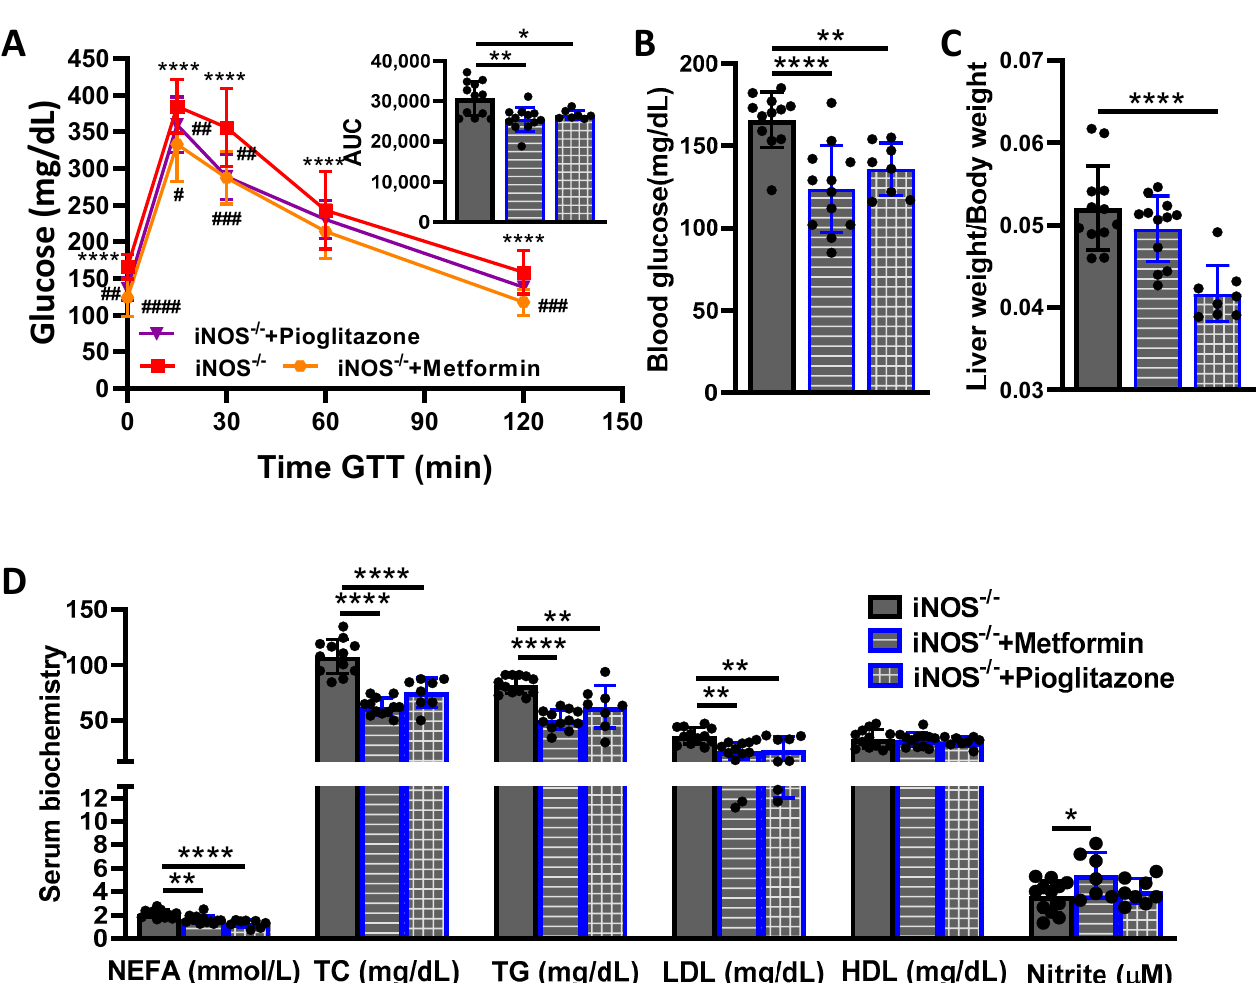
Figure 2. Effect of anti-diabetics on systemic glucose homeostasis and dyslipidemia in iNOS -/- mice. Systemic glucose and lipid homeostasis in iNOS -/- mice after treatment with metformin or pioglitazone. ( A ) Intraperitoneal glucose tolerance test (GTT) with AUC calculated from IPGTT data, ( B ) Fasting blood glucose levels, ( C ) Relative liver-body weight ratio and ( D ) Serum lipids and total nitrite levels. Data are represented as mean ± SD ( n = 7–12). * p < 0.05, ** p < 0.01 and **** p < 0.0001 between indicated groups. # p < 0.05, ## p < 0.01, ### p < 0.001 and #### p < 0.0001 vs. iNOS -/- in GTT curve.